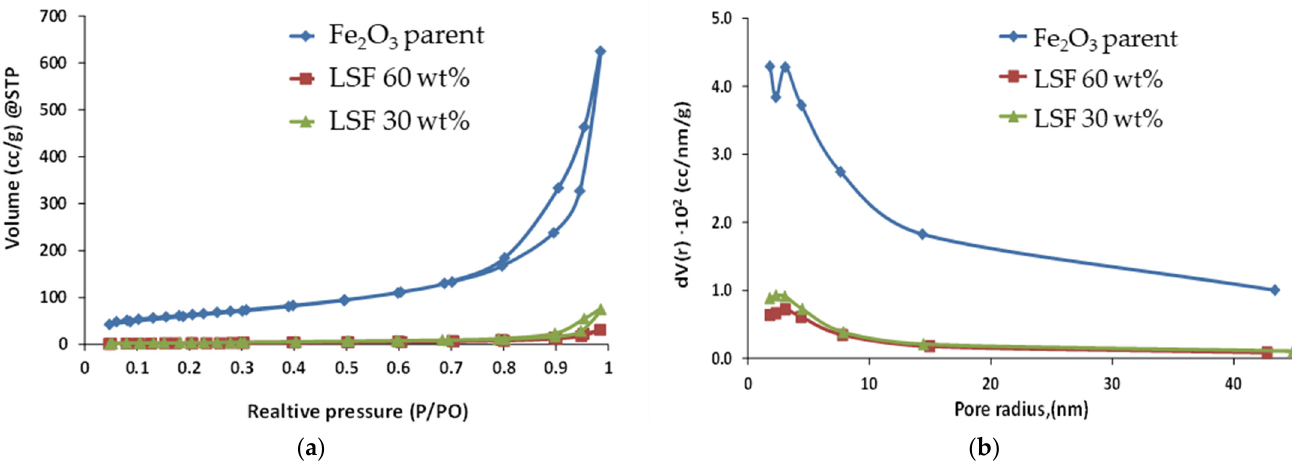
Figure 3. N 2 -adsorption-desorption isotherms ( a ) and pore size distributions ( b ) of fresh parent Fe 2 O 3 and core-shell materials CS-1 and CS-3 containing 30 and 60 LSF-perovskite, respectively.